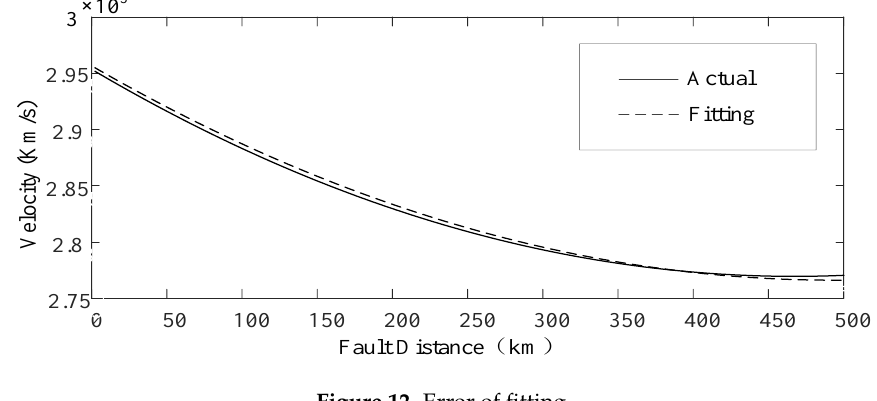
Figure 12. Error of fitting.